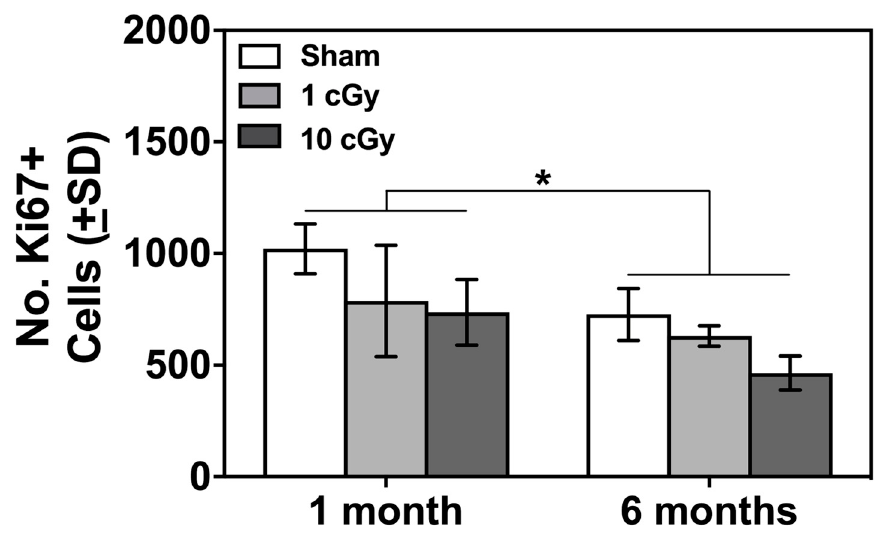
Figure4. MeannumberofKi67 + cellsinthesubventricularzone(SVZ)ofsham( n = 2–4), 1 cGy ( n = Figure 4. Mean number of Ki67+ cells in the subventricular zone (SVZ) of sham ( n = 2–4), 1 cGy ( n =